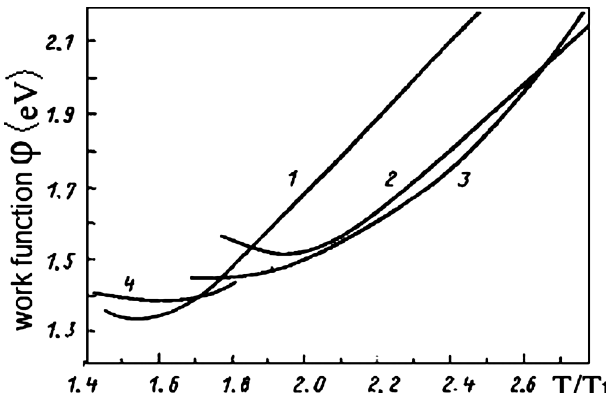
FIG. 12. The work function in the case of cesium adsorption dependence upon the ratio of sample temperature T to cesium- tank temperature Tr for collectors of (1) a molybdenum polycrystalline with a tungsten layer on the surface, (2) (110) molybdenum, (3) a molybdenum polycrystalline, and (4) an polycrystalline [25]. LaB 6